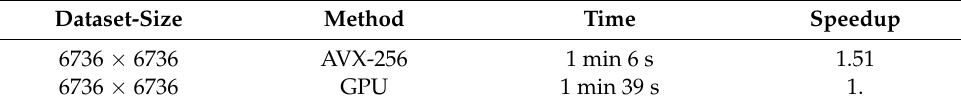
Table 8. OpenMP/AVX-256 Implementation vs. GPU speed